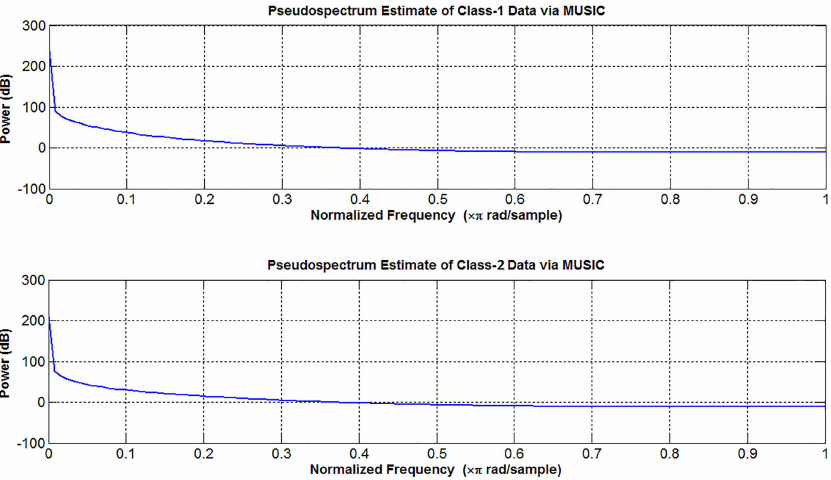
Fig 8. The frequency-amplitude representations of classes belonging to the same attribute. This attribute is also used in Fig